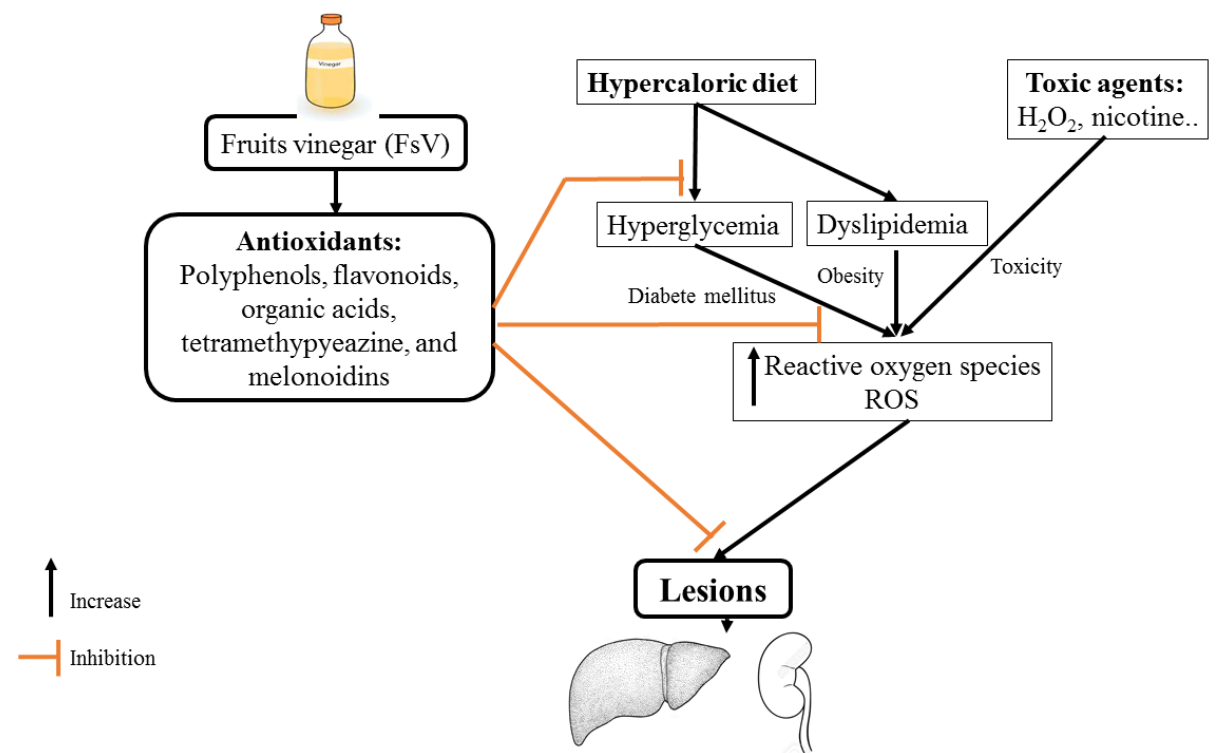
Figure 1. Mechanism of action possible of apple vinegar on nephro-hepatic functions against hydrogen peroxide and D -glucose toxicities.